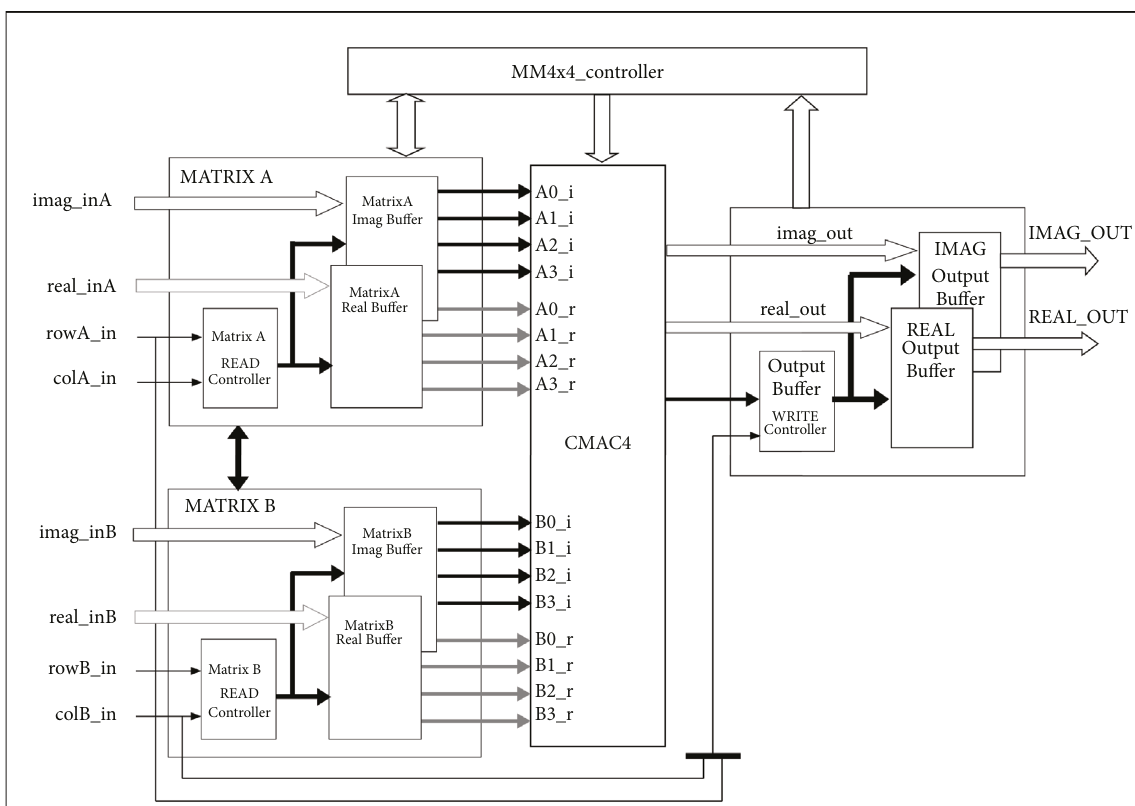
Figure 5: Block diagram of the Complex Matrix Multiplier module.